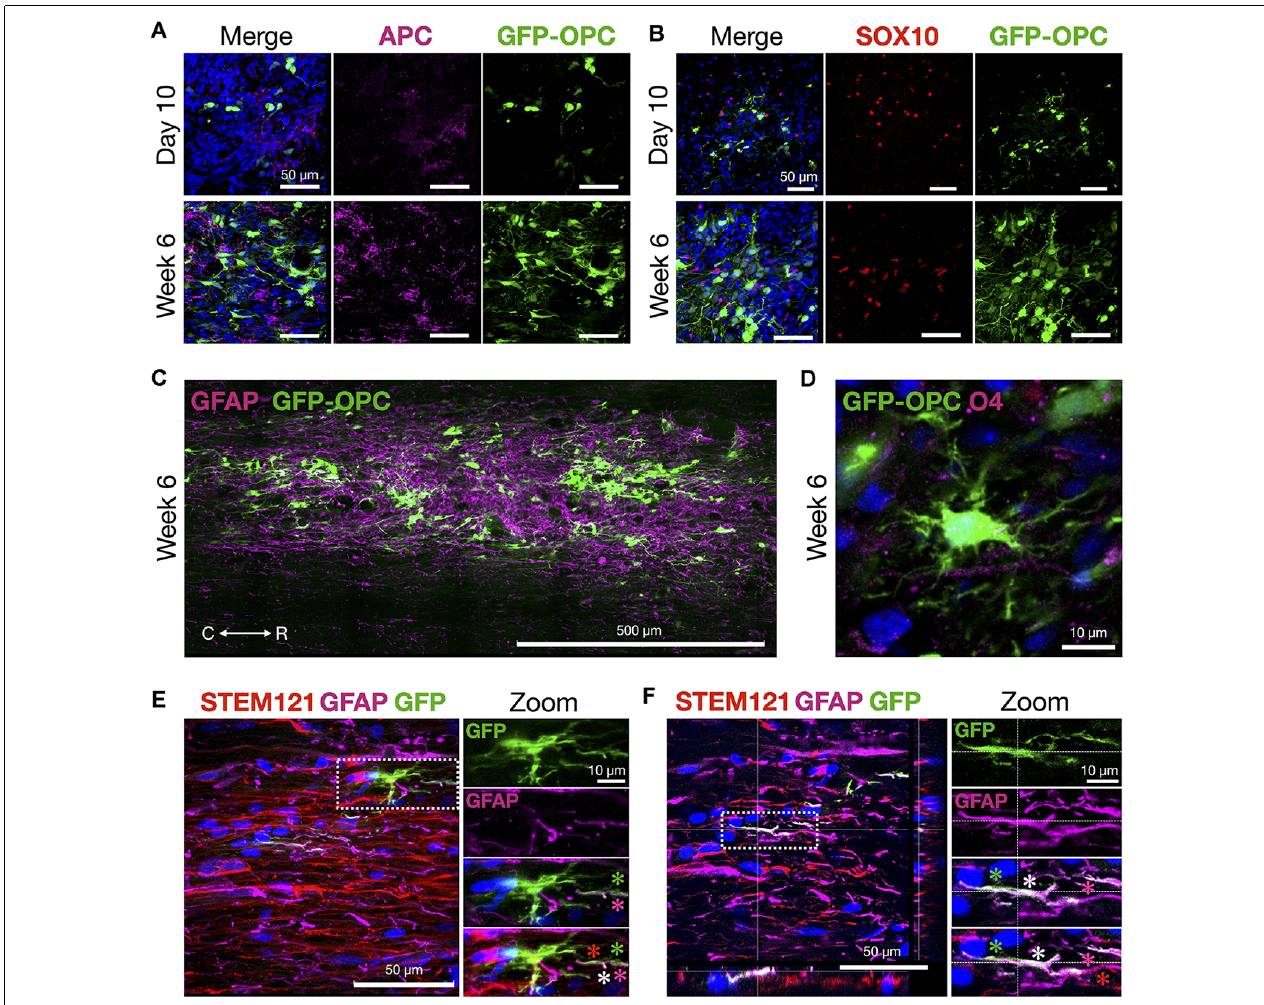
FIGURE 7 | OPCs thrive and morphologically develop in the contusion injury site. (A) Mature oligodendrocyte marker APC and transplanted GFP-OPCs at 10 days and 6 weeks time points, counterstained with DAPI. (B) GFP-OPCs increase in morphological complexity over 6 weeks in association with SOX10+ cells in the contusion injury microenvironment. Ten days and 6 weeks time points shown with DAPI. (C) GFP-OPCs survive and integrate within the GFAP+ injury milieu by 6 weeks. (D) GFP-OPCs arborize in the contusion injury microenvironment. O4 staining shown with DAPI. (E,F) Analysis of GFP-OPC and GFAP signal overlap at 6 weeks. GFAP and GFP signal is distinct with regions of overlap along STEM121 neural processes. Two examples are provided with zoom images. Asterisks depict GFP-OPC (green), GFAP (magenta), STEM121 (red), and signal overlap (white). R (rostral), C (caudal). Individual scale bars are